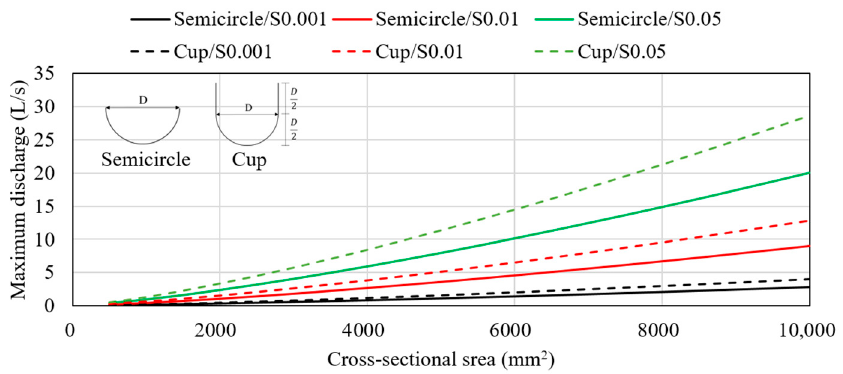
Figure 7. Flow capacity of two sub-pipes under the same conditions ( n = 0.013 s/m 1/3 ).